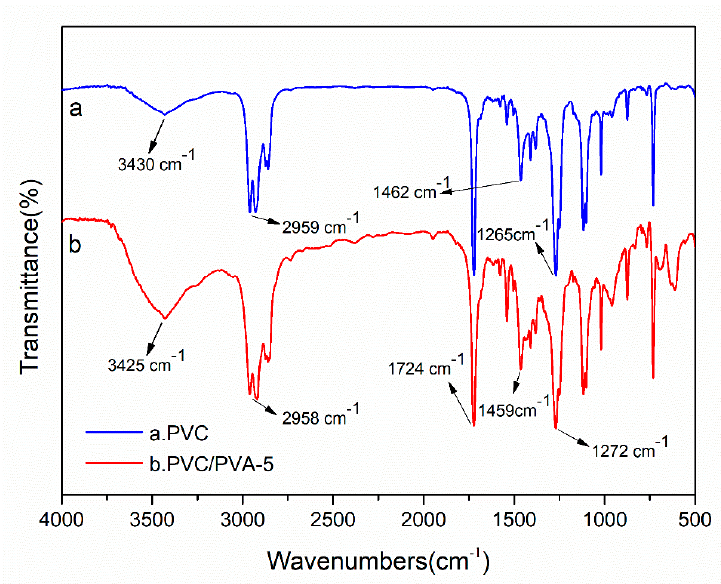
Figure 8. Fourier transform infrared (FTIR) spectra of ( a ) PVC and ( b ) PVC/PVA-5.